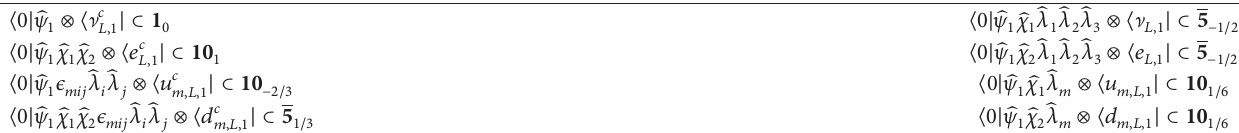
Table 1: Fermionic states of the 1st chiral generation of the SM. In our indication of the 𝑆𝑈(5) multiplet to which each state belongs we use the notation n 𝑌 where 𝑛 is the dimension of the 𝑆𝑈(5) representation in which the state transforms and 𝑌 is the ( 𝑆𝑈(5) ) 𝑈(1) 𝑌